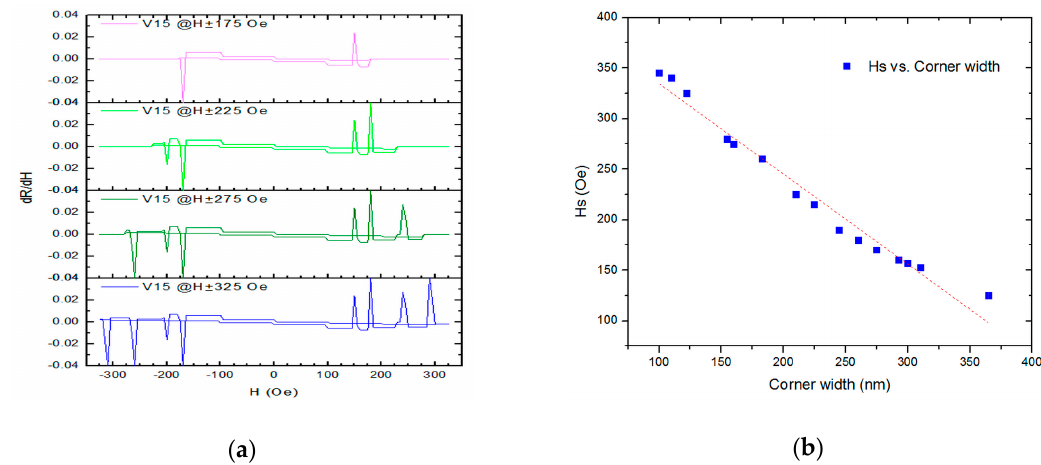
Figure 5. ( a ) The differential value of dR/dH versus H for the minor loop of the wider half-ring wire with a maximum of 4 jumps. ( b ) The switching field versus corner width as finite-size effect, where the dash line is the result of a linear fit.